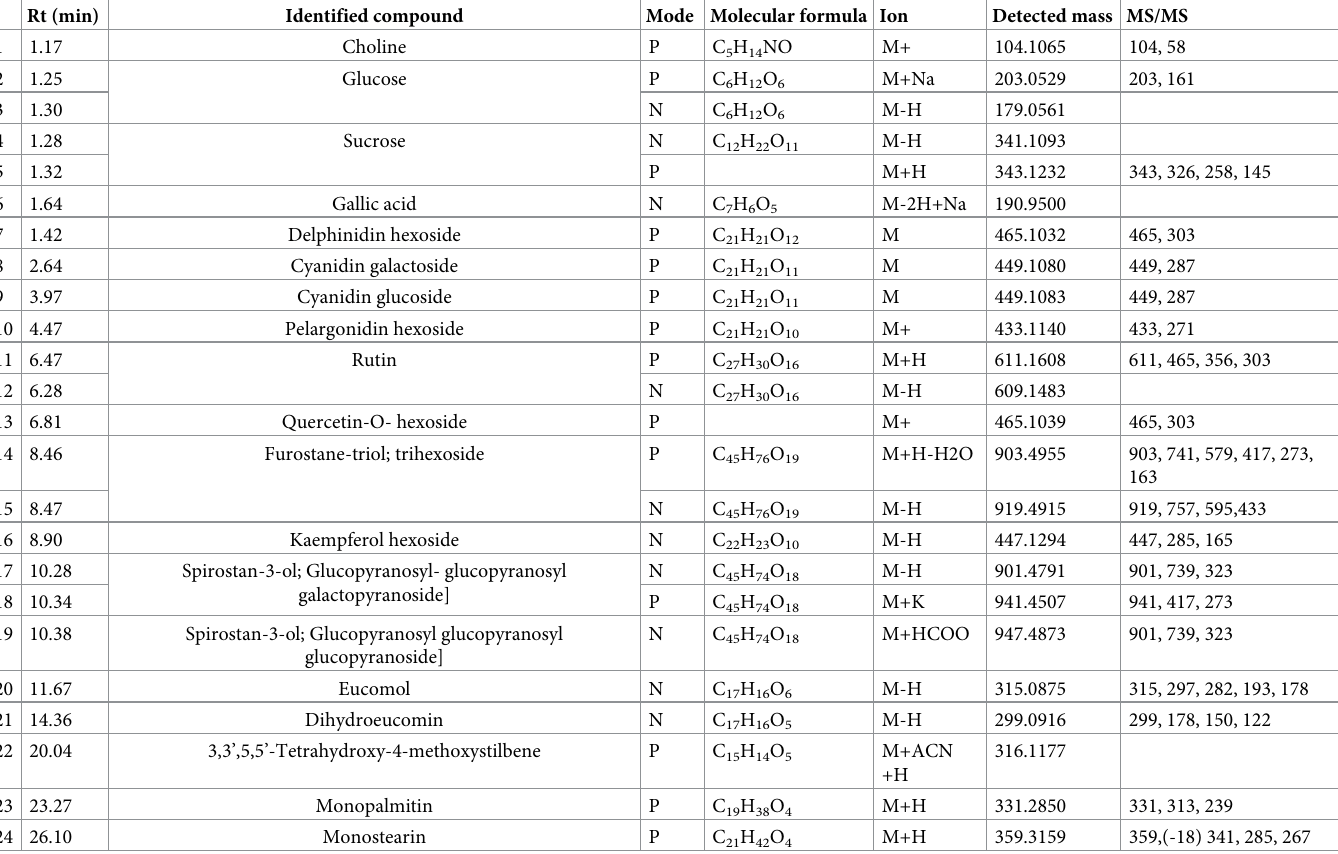
Table 1. Major metabolites detected in Yucca aloifolia fruits via nano LC-HRMS/MS. Rt (min) Identified